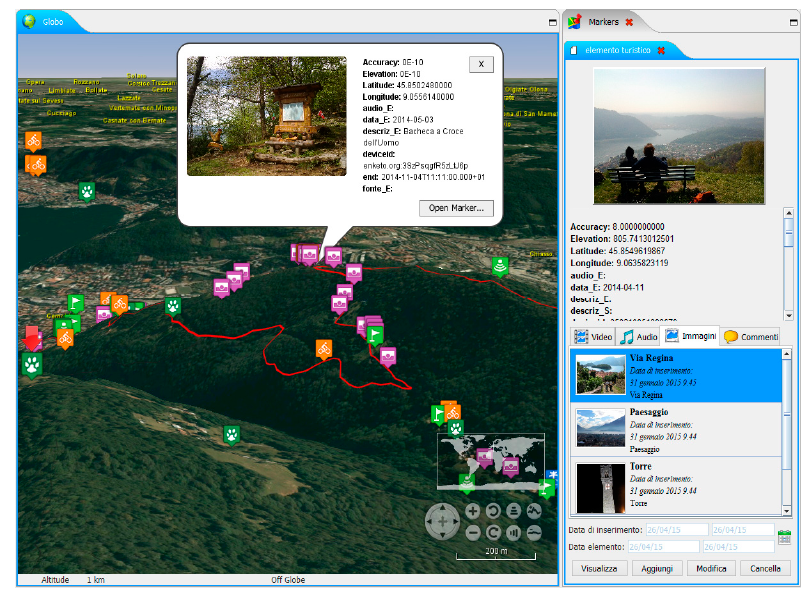
Figure 3. Virtual globe based on NASA World Wind for sharing and managing user generated content.